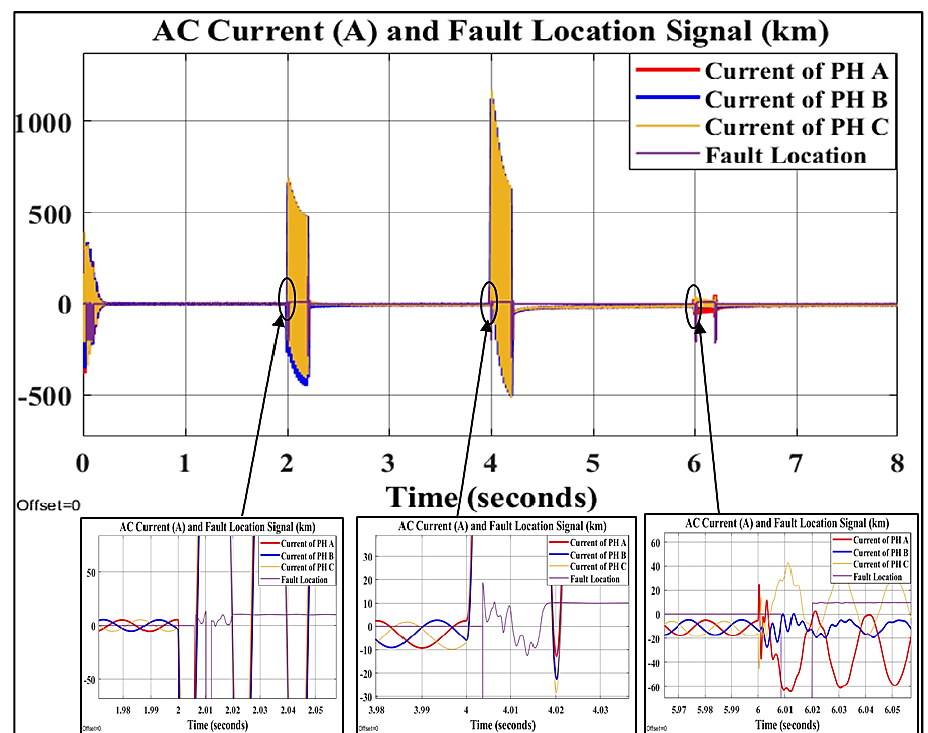
Figure 22. AC bus current and fault detection signal .